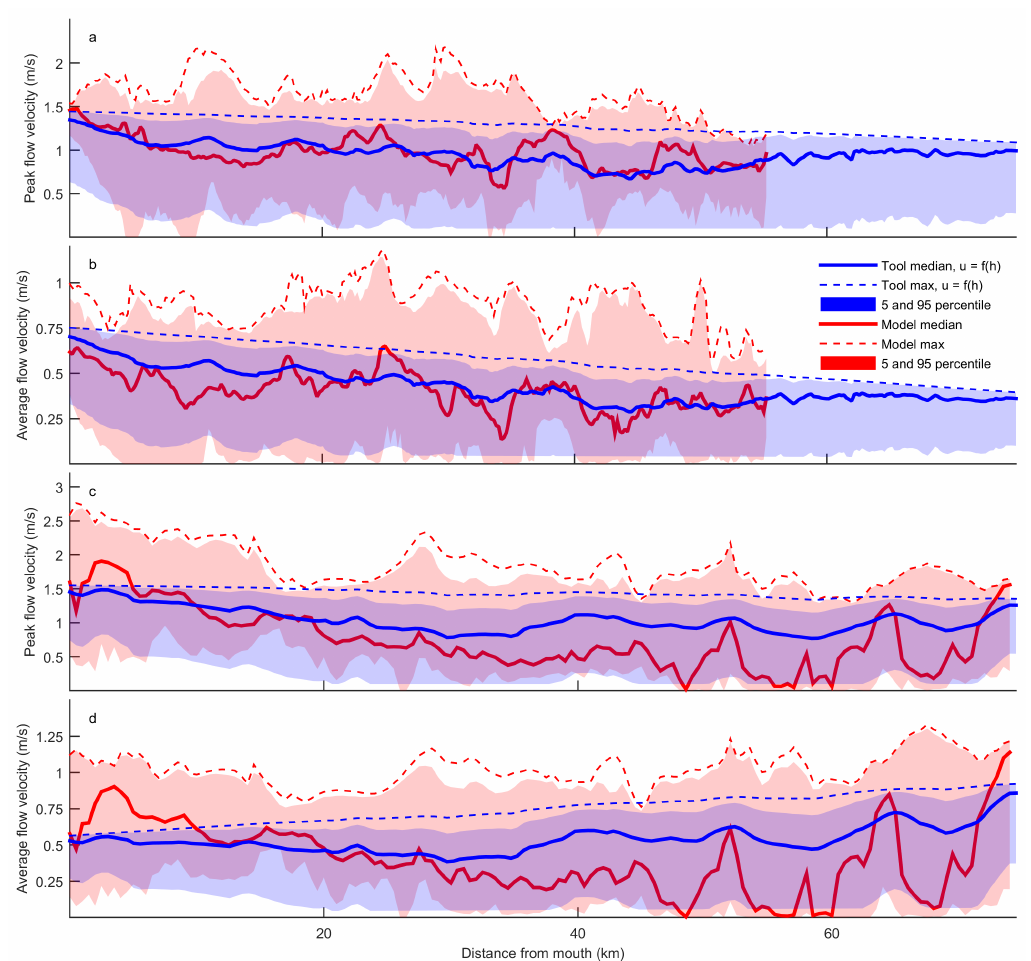
Figure 8. Comparison between modelled [red] and predicted [blue] flow velocities along the Western Scheldt ( a , b ) and the Columbia River ( c , d ). Shaded area shows the range of peak velocities ( a,c ) and range of average velocities over half a tidal cycle ( b , d ) bounded by the 5 and 95 percentile values. The solid line indicates the median and dashed line maximum value per